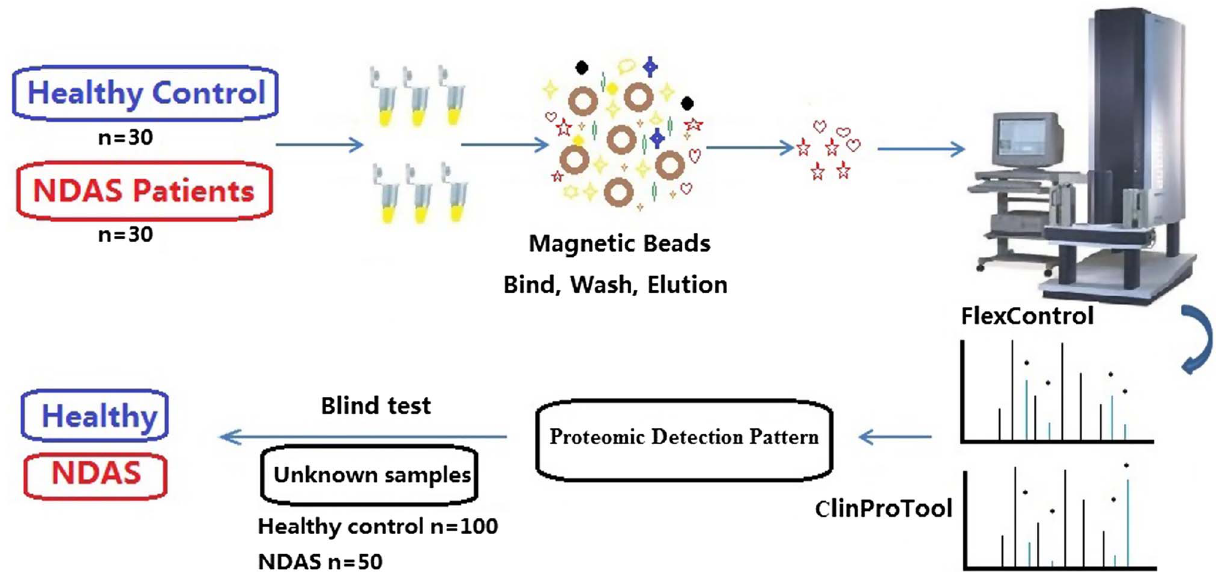
Figure 1. The study design, including sample collection and preparation, MALDI-TOF MS and blind